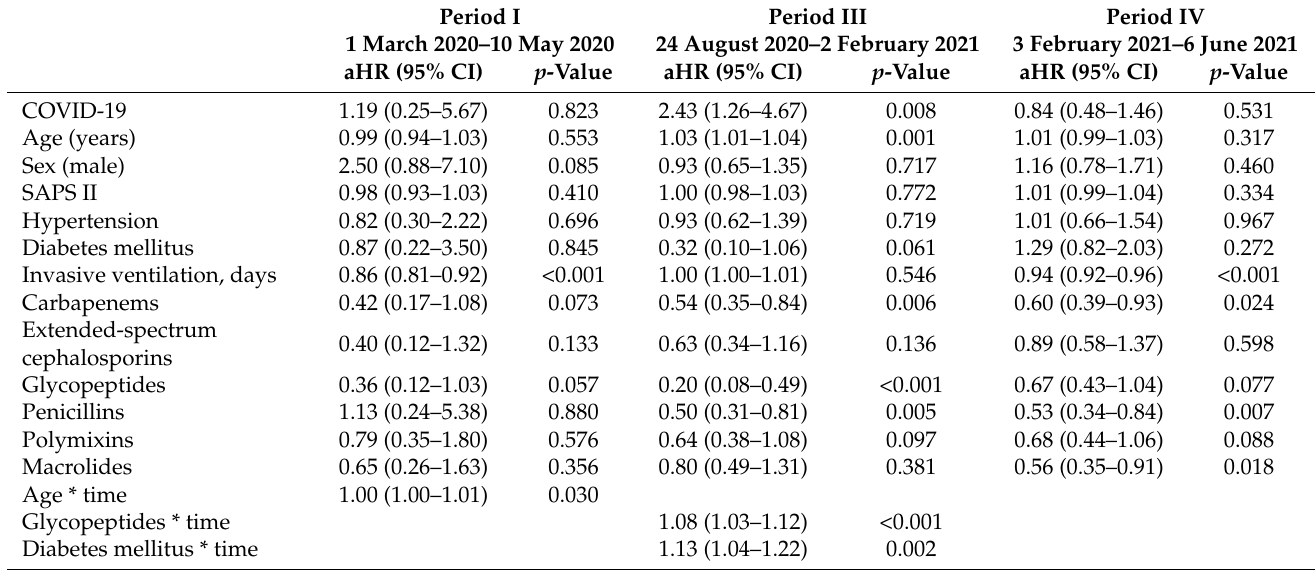
Table 2. Multivariable conditional risk set regression models for time to healthcare-associated infection (HAI) occurred among the patients admitted to the Intensive Care Unit of Umberto